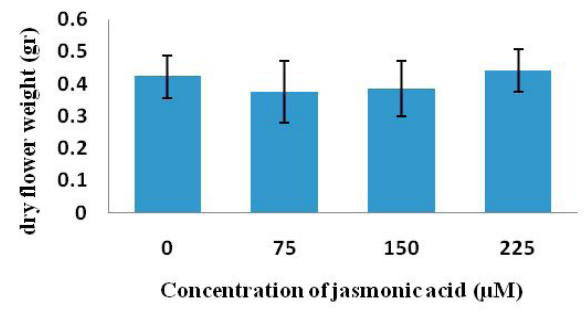
Fig. 3. Effect of different concentration of jasmonic acid on dry